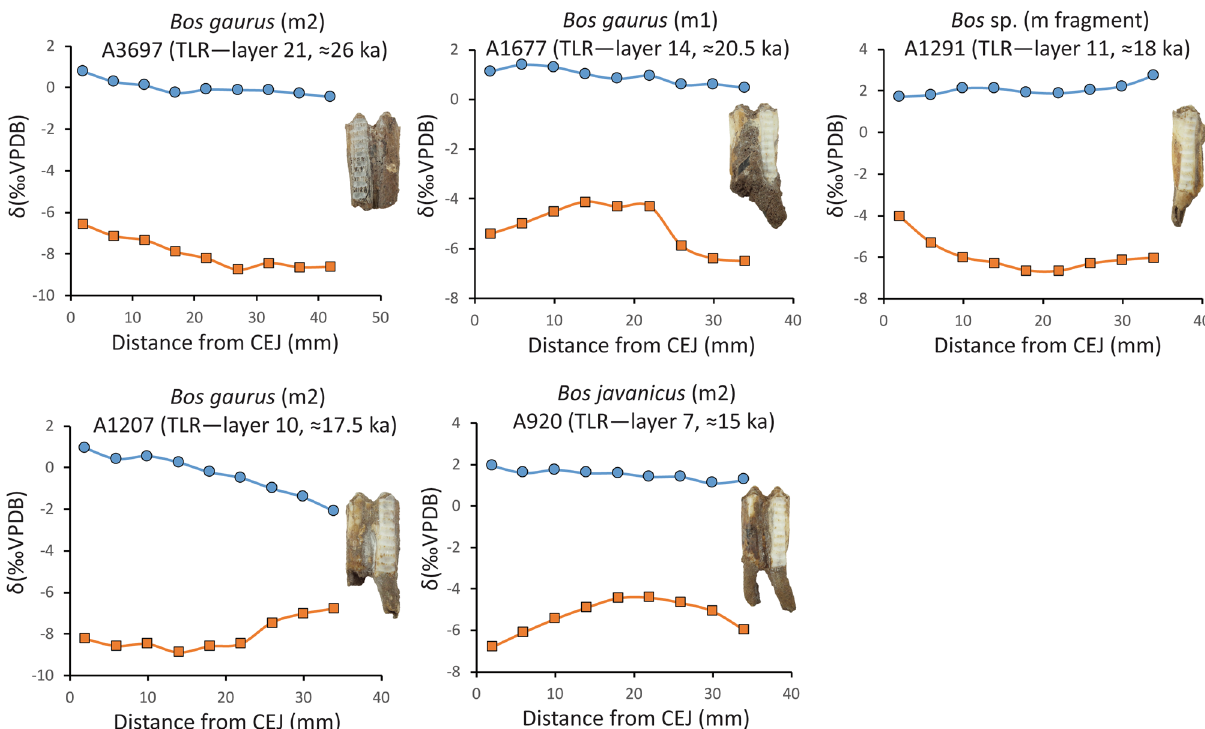
Figure 4. Sequential tooth enamel δ 13 C (blue circle) and δ 18 O (orange square) records along the crown height of large bovids. TLR (Tham Lod Rockshelter) and CEJ (Cemento-enamel